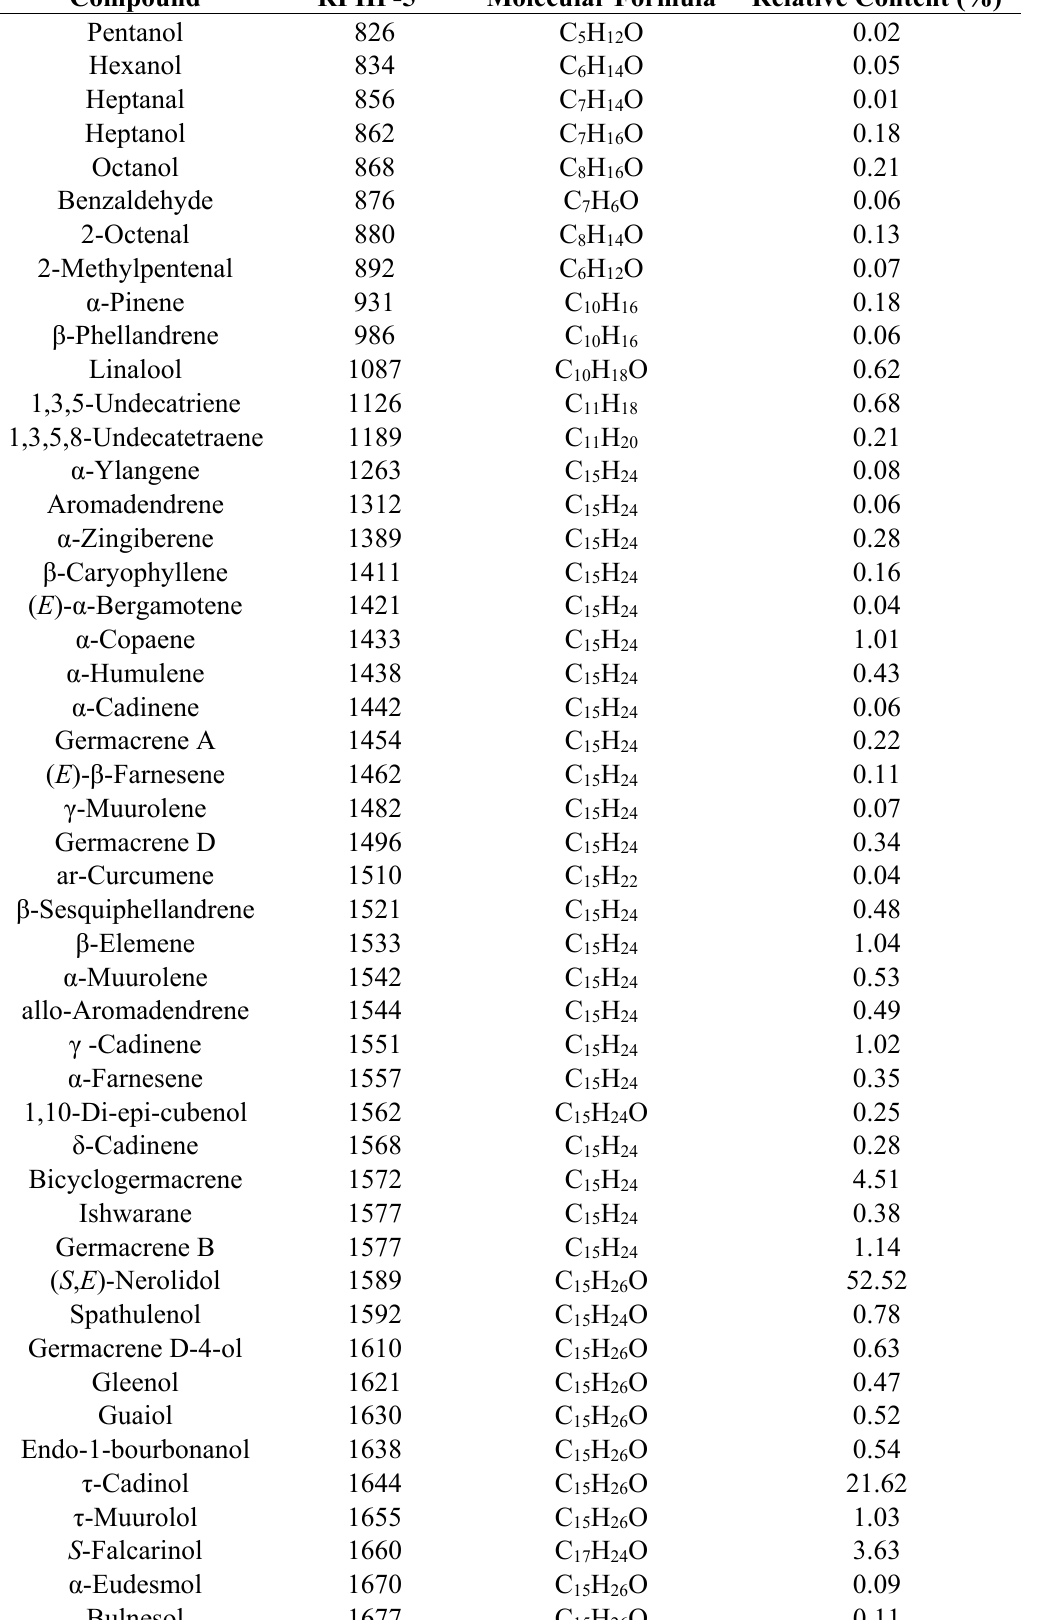
Table 2. The chemical composition of essential oil from the roots bark of O. horridus .